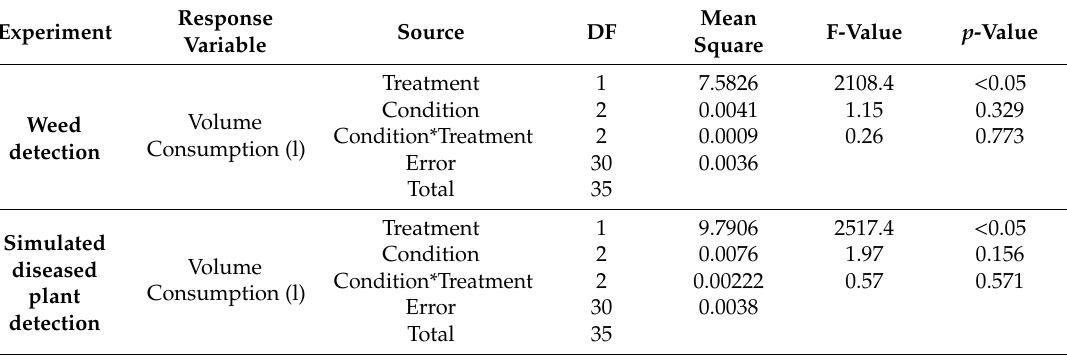
Table 6. Two-way ANOVA comparison to observe the e ff ect of di ff erent weather conditions (cloudy, partly cloudy and sunny) on spraying application techniques and their interactions for weed and simulated disease experiments using a smart variable rate sprayer at lab